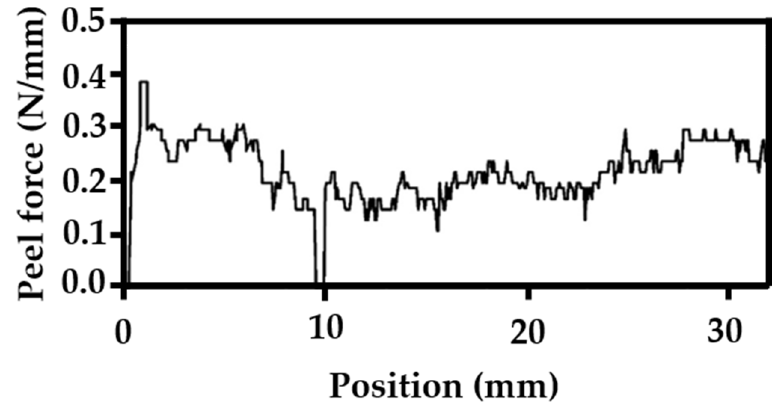
Figure 6. The peel-force measurement of E-Cu/Cu/AZO/Si sample.